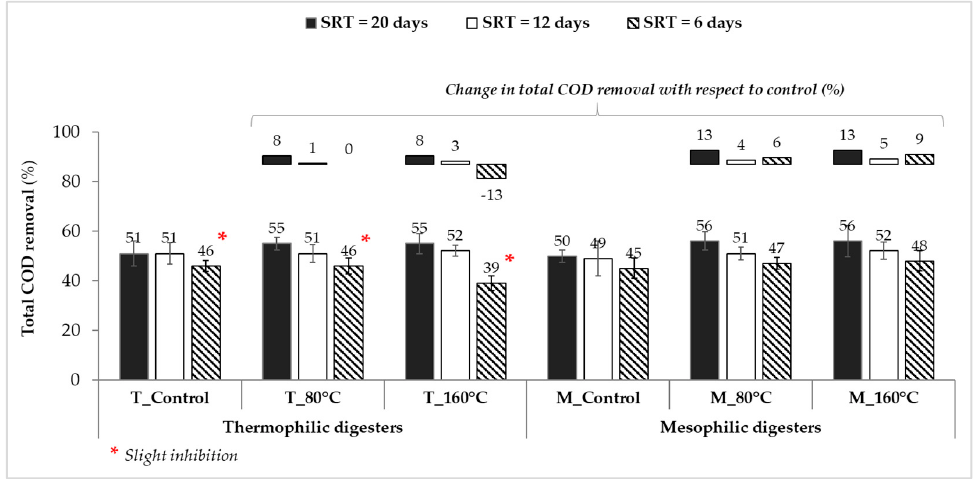
Figure 4. Average total chemical oxygen demand (COD) removal efficiencies of thermophilic and mesophilic anaerobic digesters at SRTs of 20, 12, and 6 days.